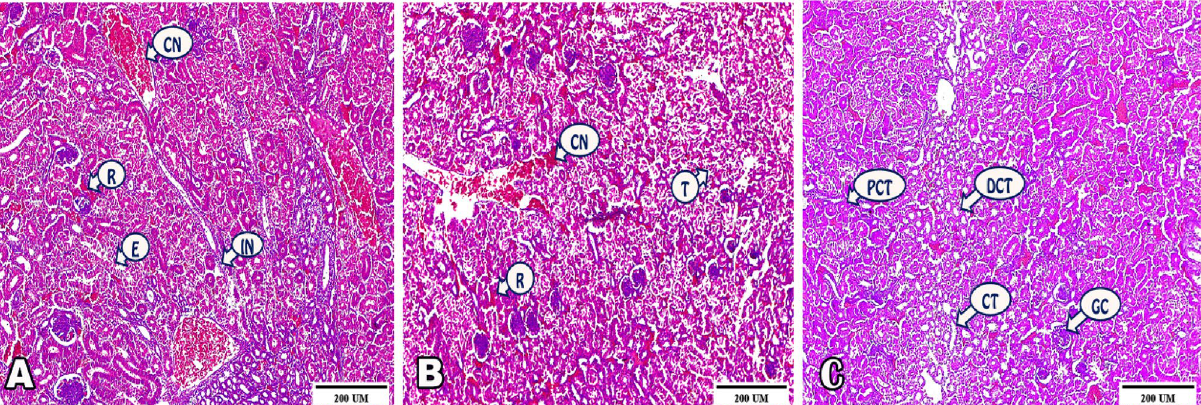
Figure 3. ( A – C ) Photomicrographs revealing the outcome of ZnONPs supplement on renal cortex structure of the examined broilers. ( A ) Section in 40 mg ZnONPs group exposed congested vessels (CN), extravasation of blood cells between renal tubules (R), inflammatory cells infiltration (IN), and exudate inside some tubules (E). ( B ) Section in 60 mg ZnONPs group highlighted degeneration of renal tubules (T), extravasated RBCS (R), and congestion in blood vessels (CN). ( C ) Section in negative group demonstrated normal structure of renal cortex; glomerular corpuscle (GC), proximal convoluted tubules (PCT), distal convoluted tubules (DCT), and collecting tubules (CT). (H&E staining, 100 × magnification, scale bar = 200